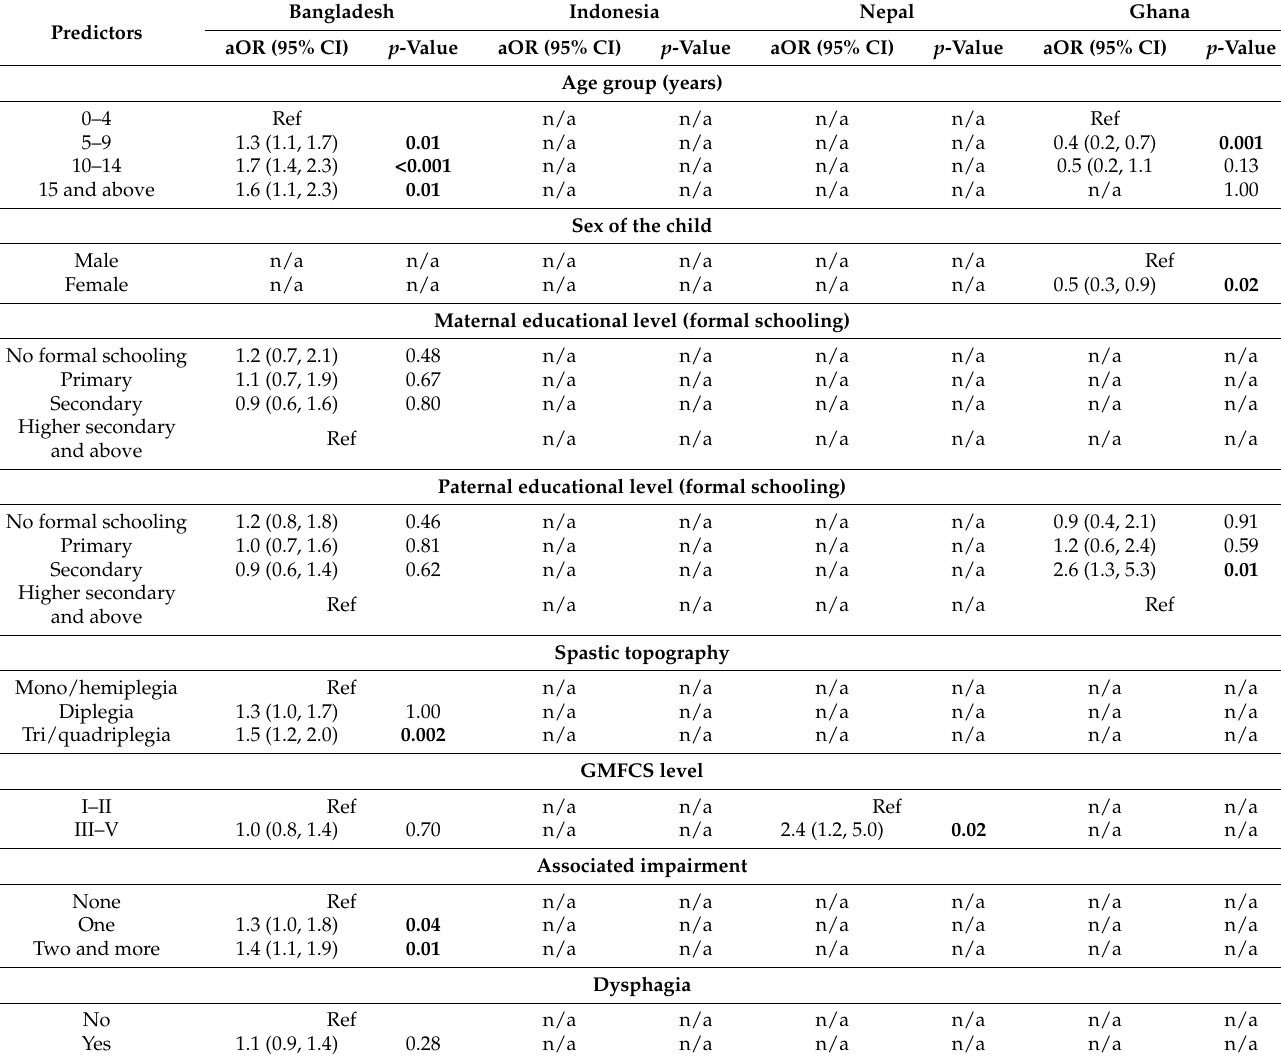
Table 6. Predictors of thinness (BAZ < − 2SD) among children with CP registered in the GLM CPR (adjusted odds